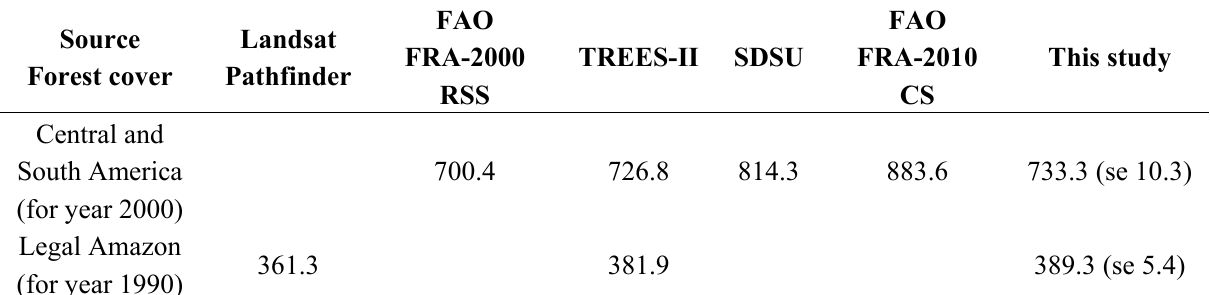
Table 3. Tropical forest cover estimates for (i) South & Central America region for year 2000 and (ii) Brazilian Legal Amazon for year 1990 from different sources—from oldest to most recent publication date (in 10 6